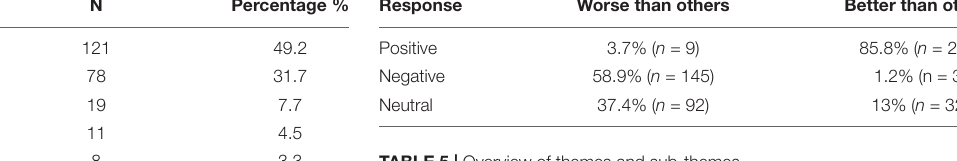
TABLE 5 | Overview of themes and